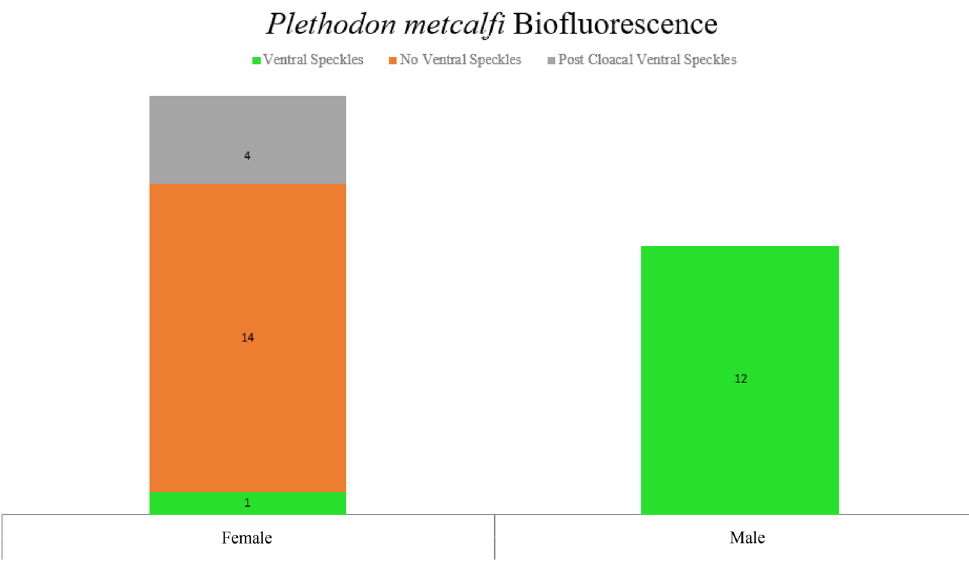
Figure 3. Bar graph showing the number of biofluorescent phenotypes observed between sexes, or mental gland